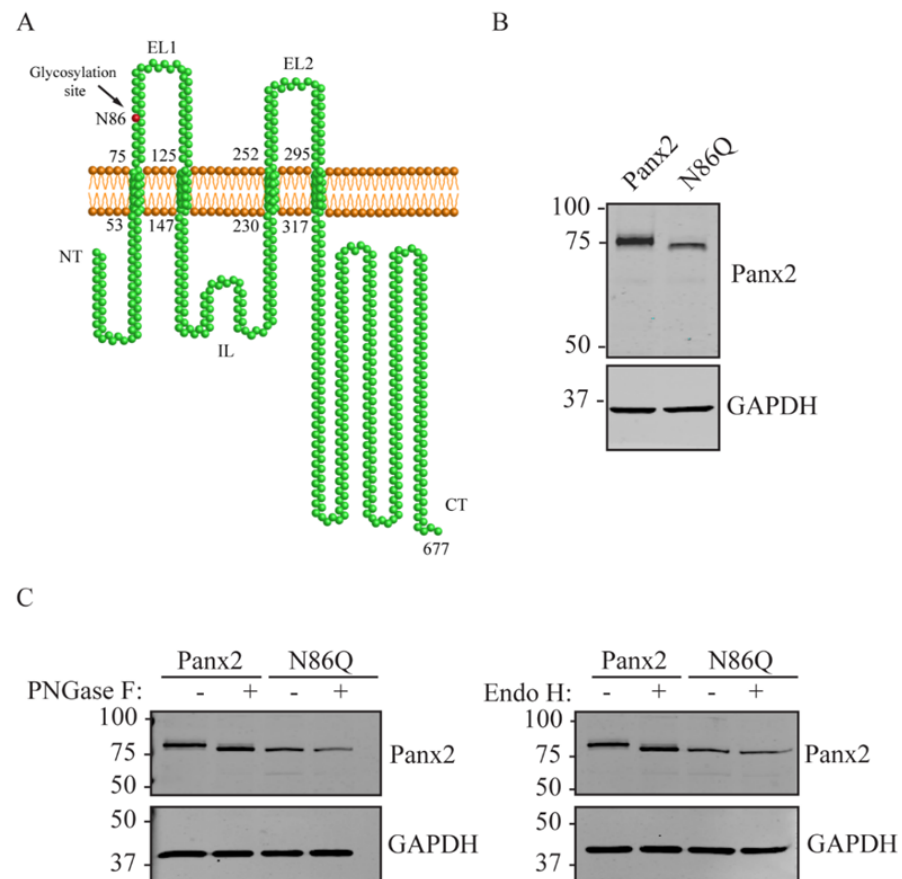
Figure 1. Asn86 is the N-glycosylation site of Panx2. ( A ) Based on sequence analysis, Panx2 (Uniprot ID: Q6IMP4-1) is predicted to contain four transmembrane domains, one intracellular (IL) and two extracellular loops (EL). The predicted N-glycosylation site is located at Asn86 in the first extracellular loop (EL1) (red residue). ( B ) Western blot (WB) comparing wildtype Panx2 and mutant N86Q, the latter shows a faster migrating band than the wildtype counterpart, indicative of decreased molecular weight. ( C ) Cell lysates of HEK293T transiently expressing Panx2 and N86Q mutant were subjected to enzymatic digestions with PNGase F and EndoH N-glycosidases. WB analysis confirmed that N86 is the only glycosylation site for Panx2 since only the wildtype protein exhibited a band shift after treatment with both glycosidases, and the de-glycosylated Panx2 band ran to the same position as the N86Q mutant. GAPDH was used as loading control. Molecular weights are noted in